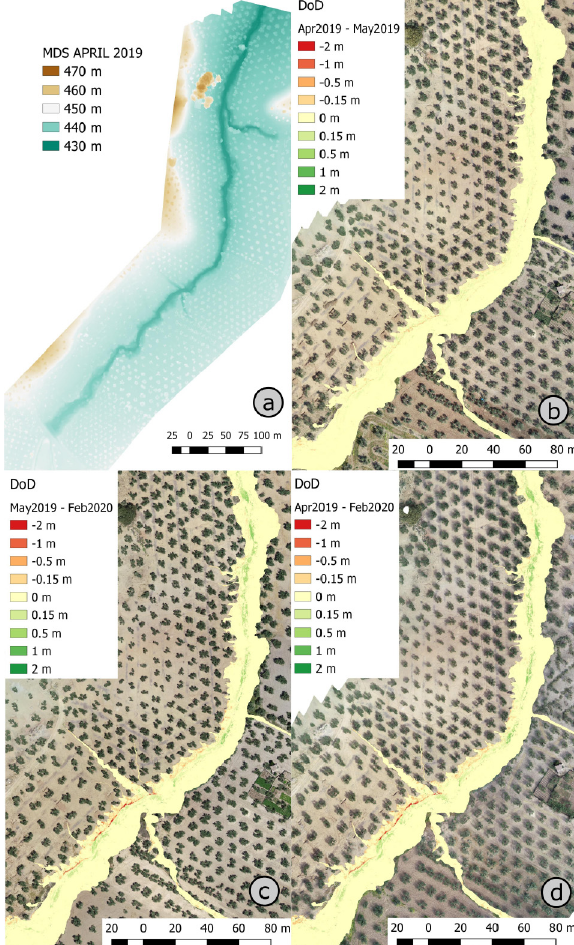
Figure 4. DSMs, orthophotographs and DoDS. a: DSM of 03- April-2019; b: Orthophotograph of 03-April-2019 and DoD of the first period; c: Orthophotograph of 14-May-2019 and DoD of the second period; d: Orthophotograph of 13-February-2020 and DoD of the whole